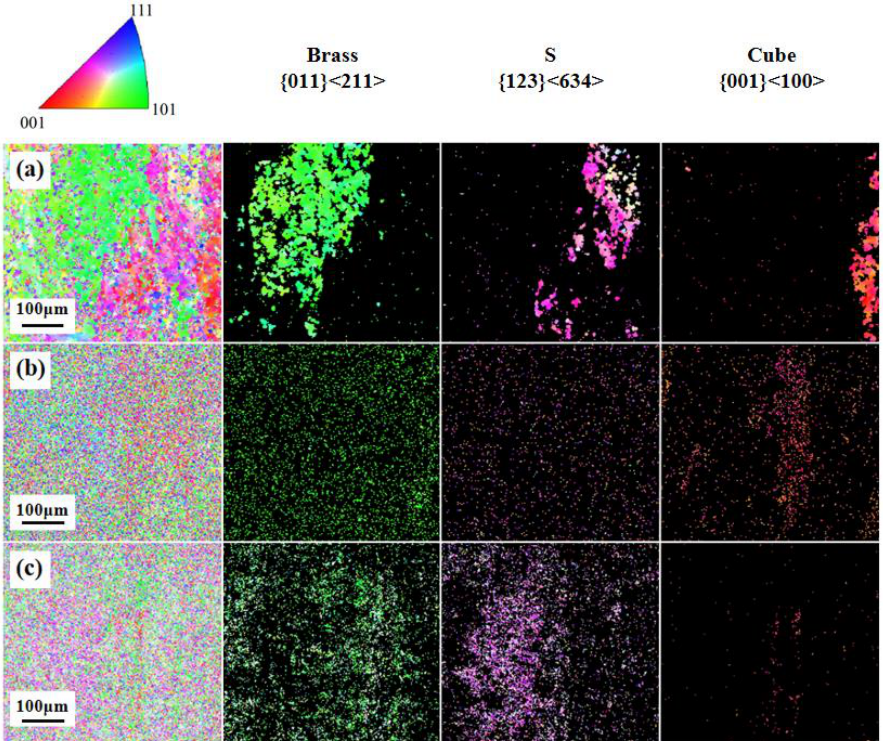
Figure 3. Microstructures of the hot-rolled state 2524-T3 alloy after cold rolling: ( a ) 10%; ( b ) 40%; ( c ) 80%.